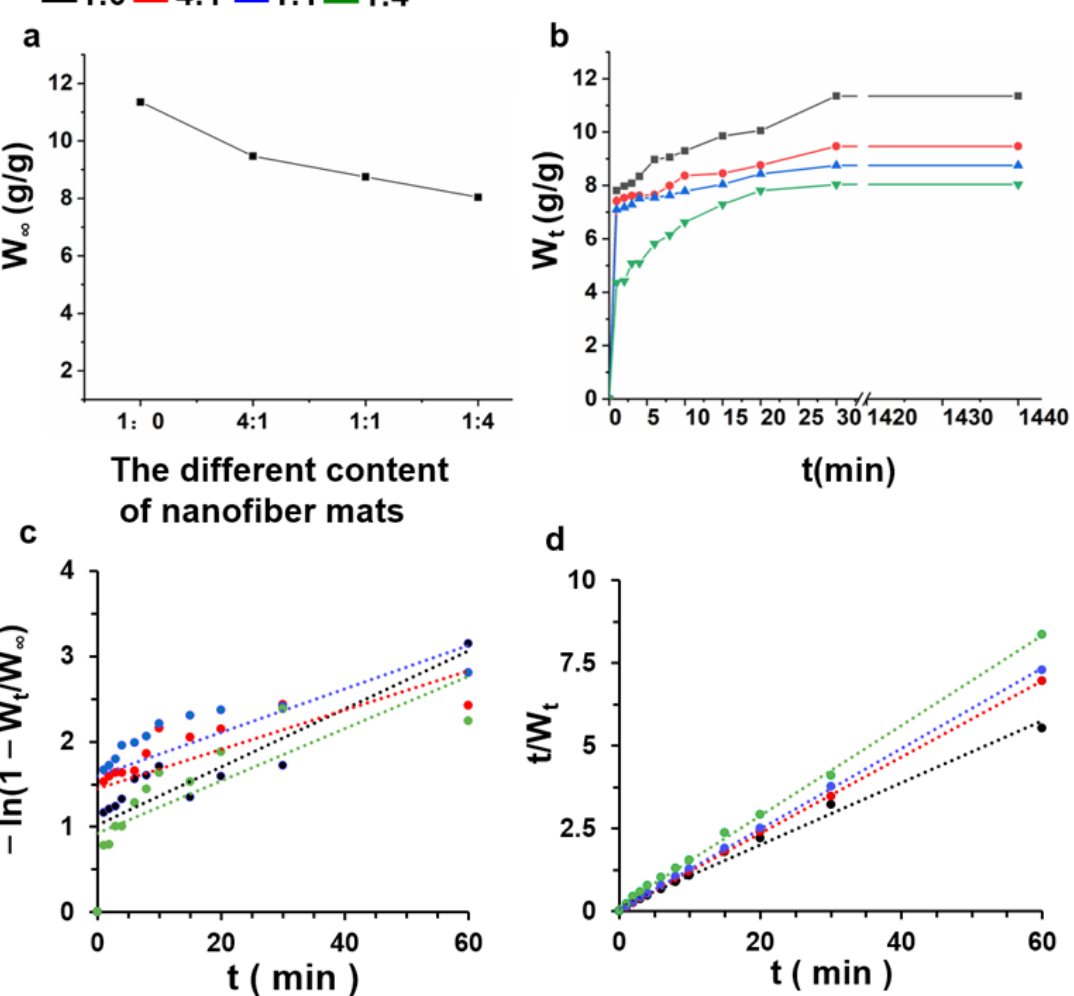
Figure 5. ( a ) The equilibrium swelling ratio, ( b ) the swelling ratio at different times, ( c ) first ‐ order fitting lines, and ( d ) second ‐ order fitting lines of different crosslinked MeGel/PLLA nanofiber mats (MeGel/PLLA = 1:0, 4:1, 1:1, and 1:4).